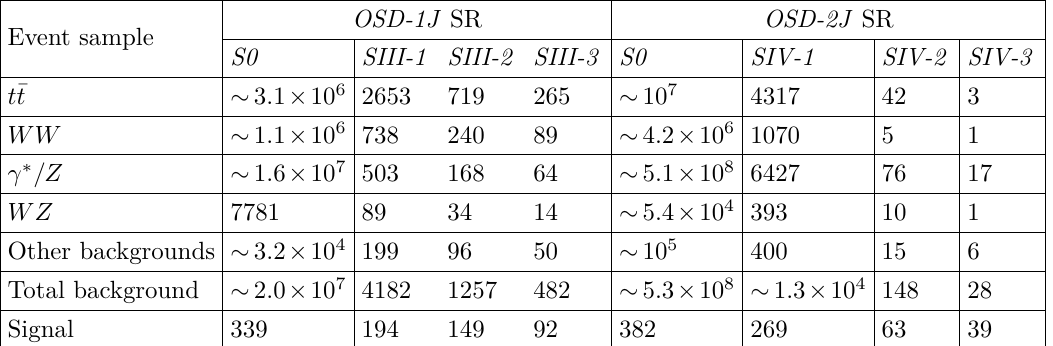
Table 8 . The numbers of expected background and signal events in OSD-1J and OSD-2J SRs after passing various selection cuts for BP1 in Model- 3 F 13 TeV